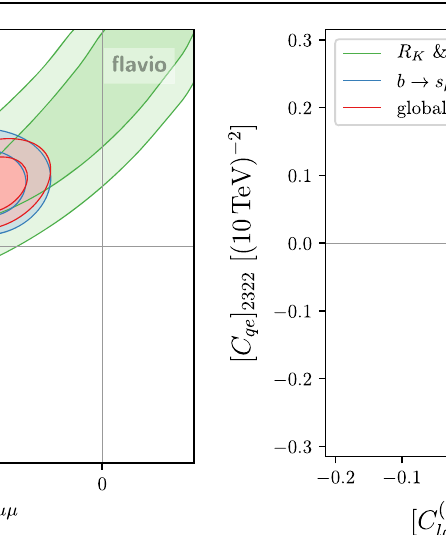
Fig. 2 Likelihood contours from b → s μμ transitions and from R K and R K ∗ in the space of the two WET Wilson coefficients C bs μμ C bs at the b quark scale (left) and the two SMEFT Wilson coeffi- 10